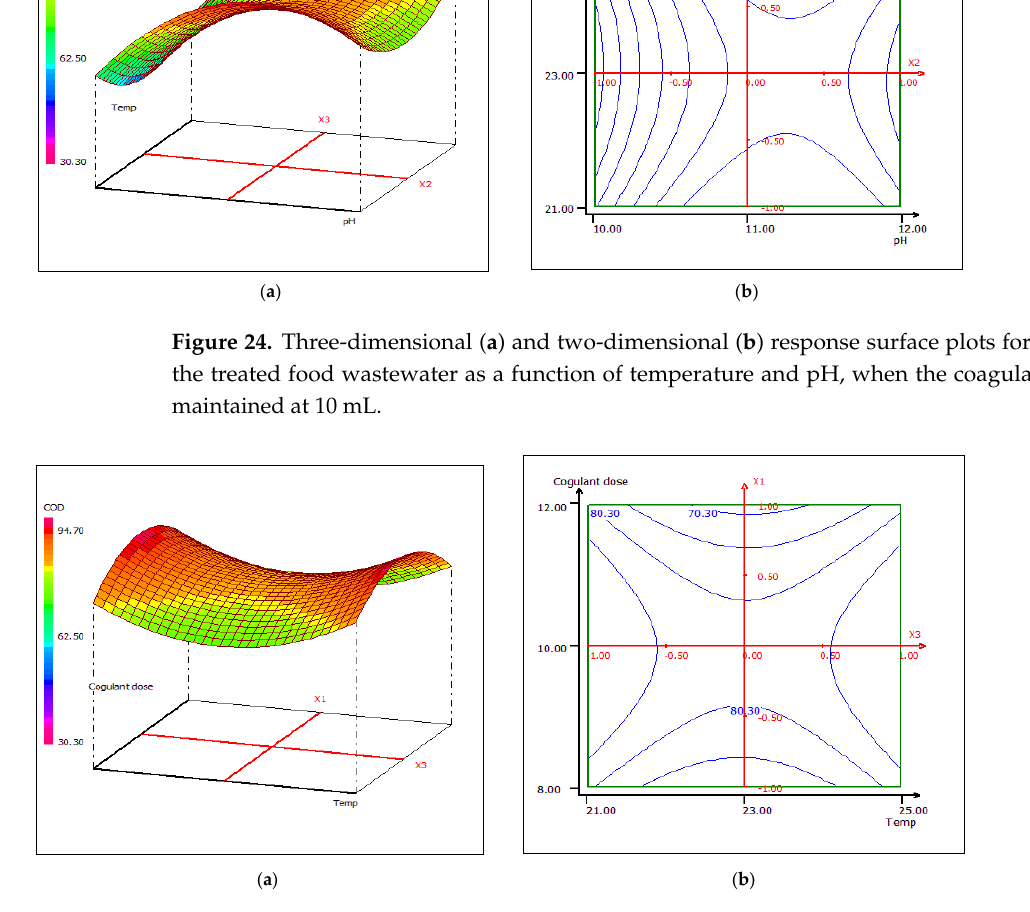
Figure 25. Three-dimensional ( a ) and two-dimensional ( b ) response surface plots for the COD of the treated food wastewater using β-chitin extract as a function of coagulant dose and temperature, when the pH was maintained at 11.